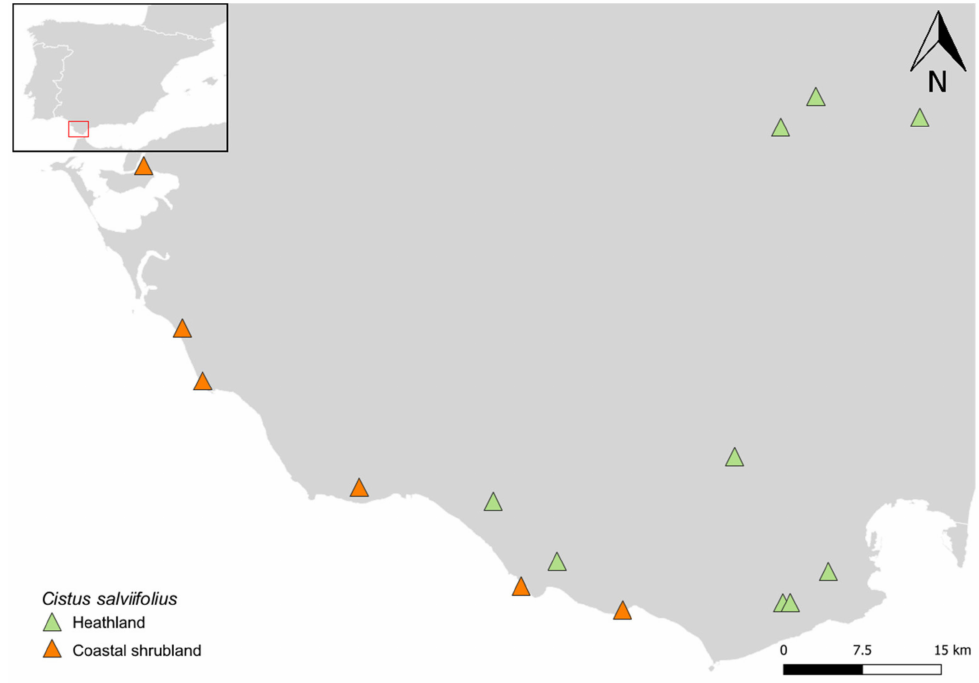
Figure 1. Site location of the sampled Cistus salviifolius populations from Mediterranean heathland (‘high-fire’) and coastal shrubland (‘low-fire’) sites in the Strait of Gibraltar area, at the southernmost tip of Spain. See Table S1 for additional information on sampling